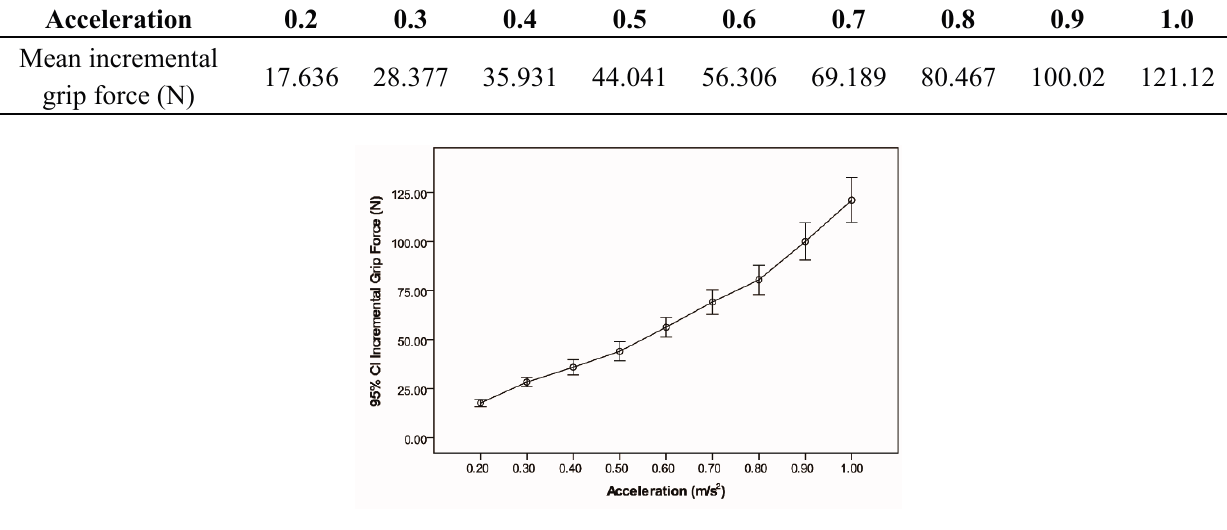
Figure 9. Incremental grip force at each